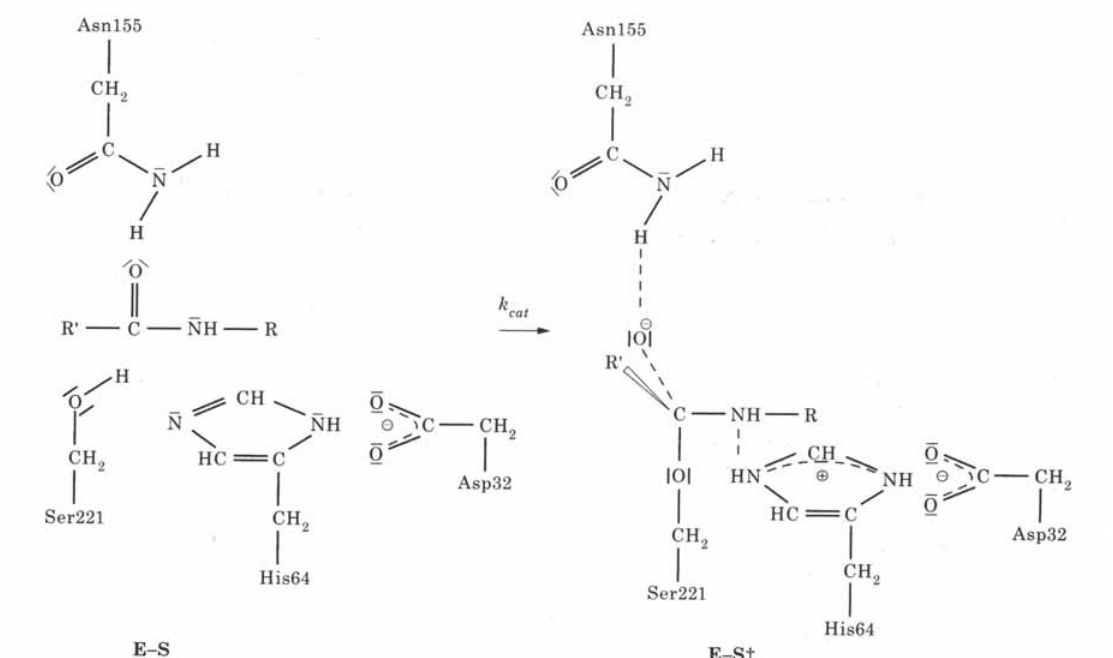
Figure 17. Schematic representation of the enzymatic reaction of serine proteases; E-S is the enzyme substrate complex, E-S ≠ the tetrahedral reaction intermediate (Reprinted with permission by Academic Press - Reference